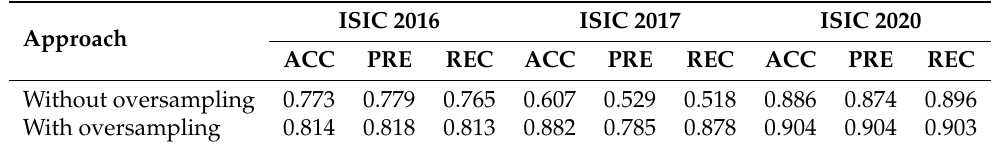
Table 5. Impact of data oversampling on the performance of LCNet.